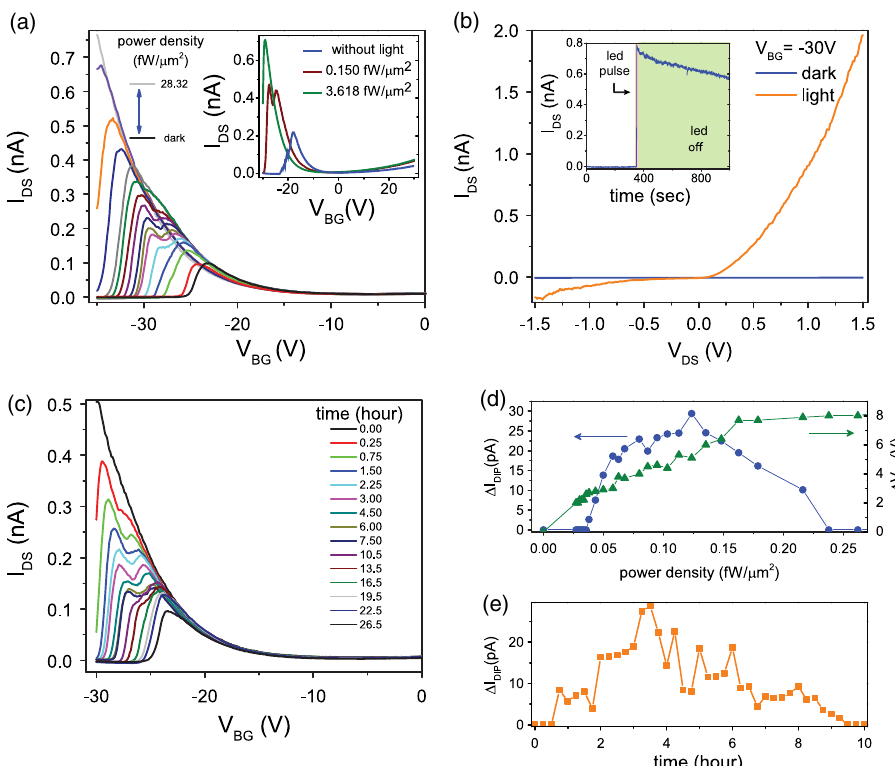
Fig. 3 a Evolution of I DS – V BG response of device D 3, with increasing light intensity ( blue ) during second cycle. The dip can be seen appearing and again disappearing with increasing optical power. Inset shows evolution of I DS – V BG during fi rst cycle. b Comparison of I DS – V DS response under dark and illuminated condition. Inset shows led pulse experiment, which shows memory effect. c Evolution of I DS – V BG with time after led was switched off. Here also the dip can be seen appearing after few hours, and then again vanishing. d , e Evolution of dip magnitude ( Δ I DIP ) with optical power density and